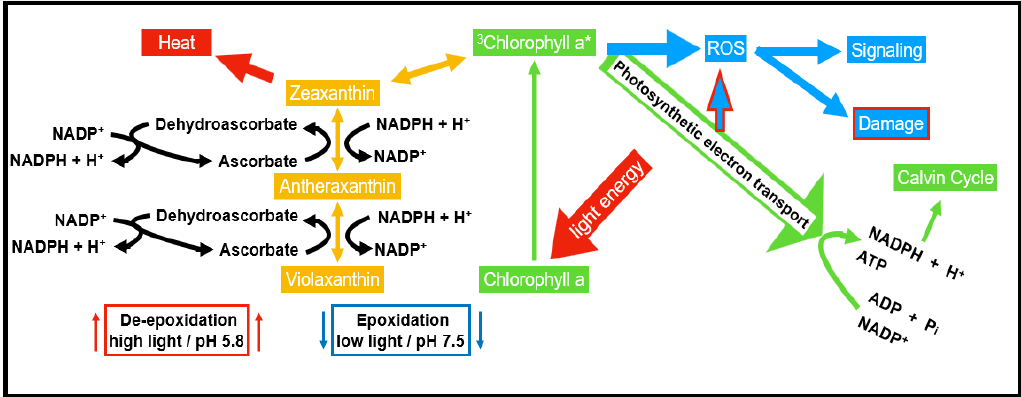
Figure 2. Absorption and display of energy in reaction centers and light-harvesting complexes. Chlorophyll a* in its triplet state is sufficiently stable to allow electron transfer reactions to redox components of the electron transport chain.